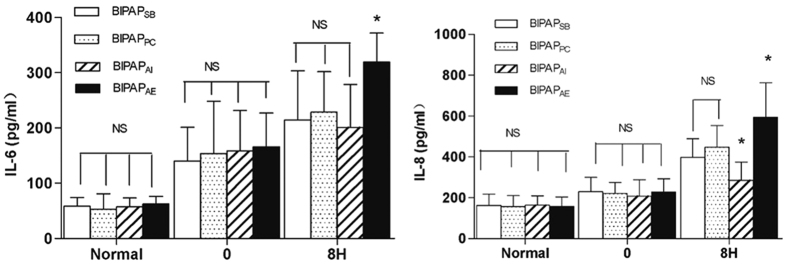
The Levels of interleukin (IL)-6 and IL-8 in plasma after 8 h mechanical ventilation.BIPAPSB = biphasic positive airway pressure with SB; BIPAPPC = biphasic positive airway pressure with muscles paralysis; BIPAPAI = biphasic positive airway pressure with inspiratory muscles activity; BIPAPAE = biphasic positive airway pressure with expiratory muscles activity. SB = spontaneous breathing; NS = no significantly difference. *P < 0.05, vs. other groups.